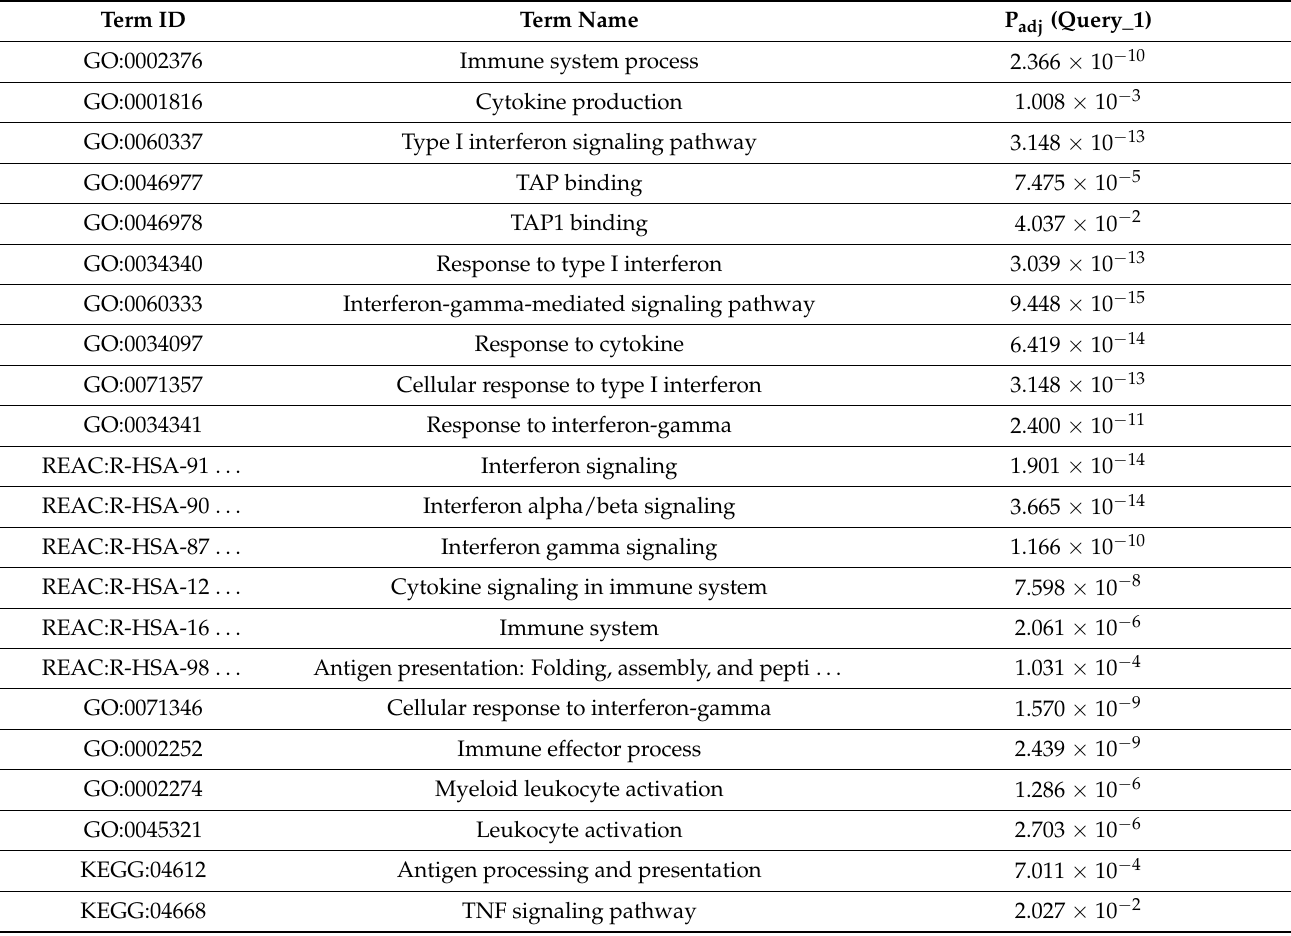
Table listing immune-system-related pathways down-regulated in MCF7-miR-18a-mimic vs. MCF7-negative control. Gene ontology and pathway analysis of DEGs were performed using ToppGene suite with the adjusted p ≤ 0.05 based on Benjamini–Hochberg false discovery